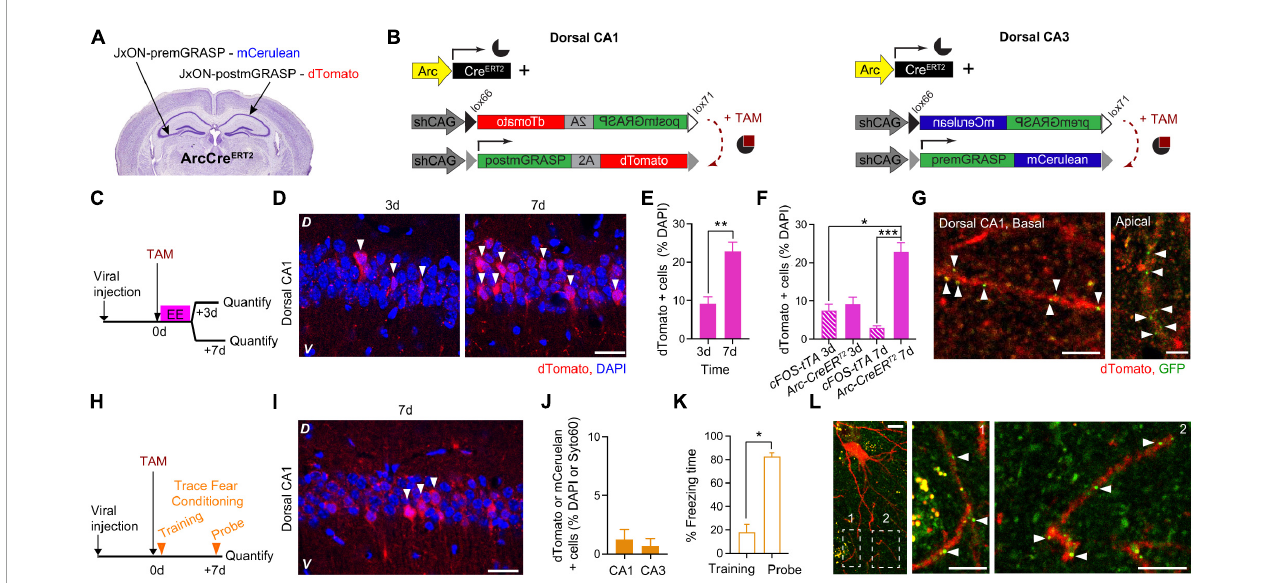
FIGURE4 ArcCre ERT2 -dependent expression of mGRASP in dCA1 upon exposure to an Enriched Environment or Trace Fear Conditioning. Schematic description of the viral injection sites in ArcCre ERT2 transgenic animals (A) and the viral constructs injected (B) . (C) Experimental design to determine the expression levels of post-mGRASP in dCA1 under the control of Arc at two different time points after exposure to EE. (D) Confocal pictures, single Z-planes, of dCA1 at different time points after induction of post-mGRASP expression. Red, dTomato; blue, DAPI. White triangles indicate dTomato-positive cells. D, Dorsal, V, Ventral. Scale bar = 20 µ m. (E) Percentage of dTomato-expressing over DAPI-positive cells in dCA1 3 and 7 days after exposure to EE. The level of dTomato at 7 days was significantly higher than at 3 days ( p = 0.0095; n 3 = 4, n 7 = 6; Mann–Whitney U-test). (F) Percentage of dTomato-expressing over DAPI-positive cells in dCA1 3 and 7 days after exposure to EE in the cFostTA (striped) or ArcCre ERT2 (solid) systems. The level of dTomato at 7 days was significantly higher in the ArcCre ERT2 system than at 3 and 7 days in the cFostTA system ( p 7dArc7dFOS = 0.0005, p 7dArc3dFOS = 0.017, all other p > 0.31; n 7dArc = 6, n 7dFOS = 5, n 3dArc = 4, n 3dFOS = 10; Kruskal–Wallis test after Dunn’s correction for multiple comparisons). (G) Confocal pictures, single Z-planes, of apical (right) and basal (left) dendritic segments of dCA1 pyramidal neurons at 7 days after induction of post-mGRASP expression showing GFP-fluorescent puncta colocalizing with dTomato-positive dendritic segments. Red, dTomato; green, GFP. White triangles indicate synaptic GFP reconstitution. D, Dorsal, V, Ventral. Scale bars = 5 µ m. (H) Experimental design to determine the dCA1 and dCA3 expression levels of post-mGRASP under the control of Arc after TFC. (I) Confocal picture, single Z-plane, of dCA1 7 days after induction of post-mGRASP expression. Red, dTomato; blue, DAPI. White triangles indicate dTomato-positive cells. D, Dorsal, V, Ventral. Scale bar = 20 µ m. (J) Percentage of dTomato- (dCA1) or mCerulean- (dCA3) expressing over DAPI- (dCA1) or Syto60- (dCA3) positive cells 7 days after exposure to FC. (K) Percentage of freezing time during the context probe 7 days after TFC training ( p = 0.015, n = 7; Wilcoxon Signed-rank test). (L) Confocal pictures, single Z-planes, of a dCA1 pyramidal neuron and dendritic segments (insets) 7 days after induction of post-mGRASP expression showing GFP-fluorescent puncta colocalizing with dTomato-positive dendritic segments. Red, dTomato; green, GFP. White triangles indicate synaptic GFP reconstitution. Inset number 2 is rotated 90 degrees from the original orientation. Scale bars: left = 10 µ m, middle and right = 5 µ m. * p < 0.05, ** p < 0.01, *** p < 0.001.